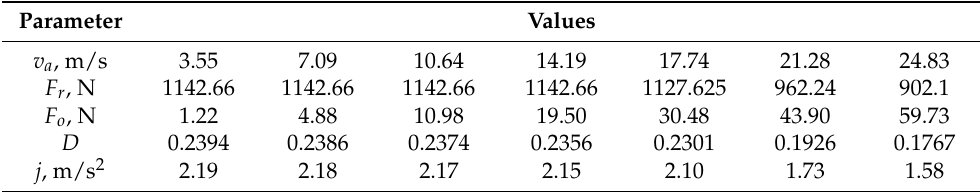
Table 3. Calculated three-wheeled tilting vehicle theoretical dynamic characteristics.